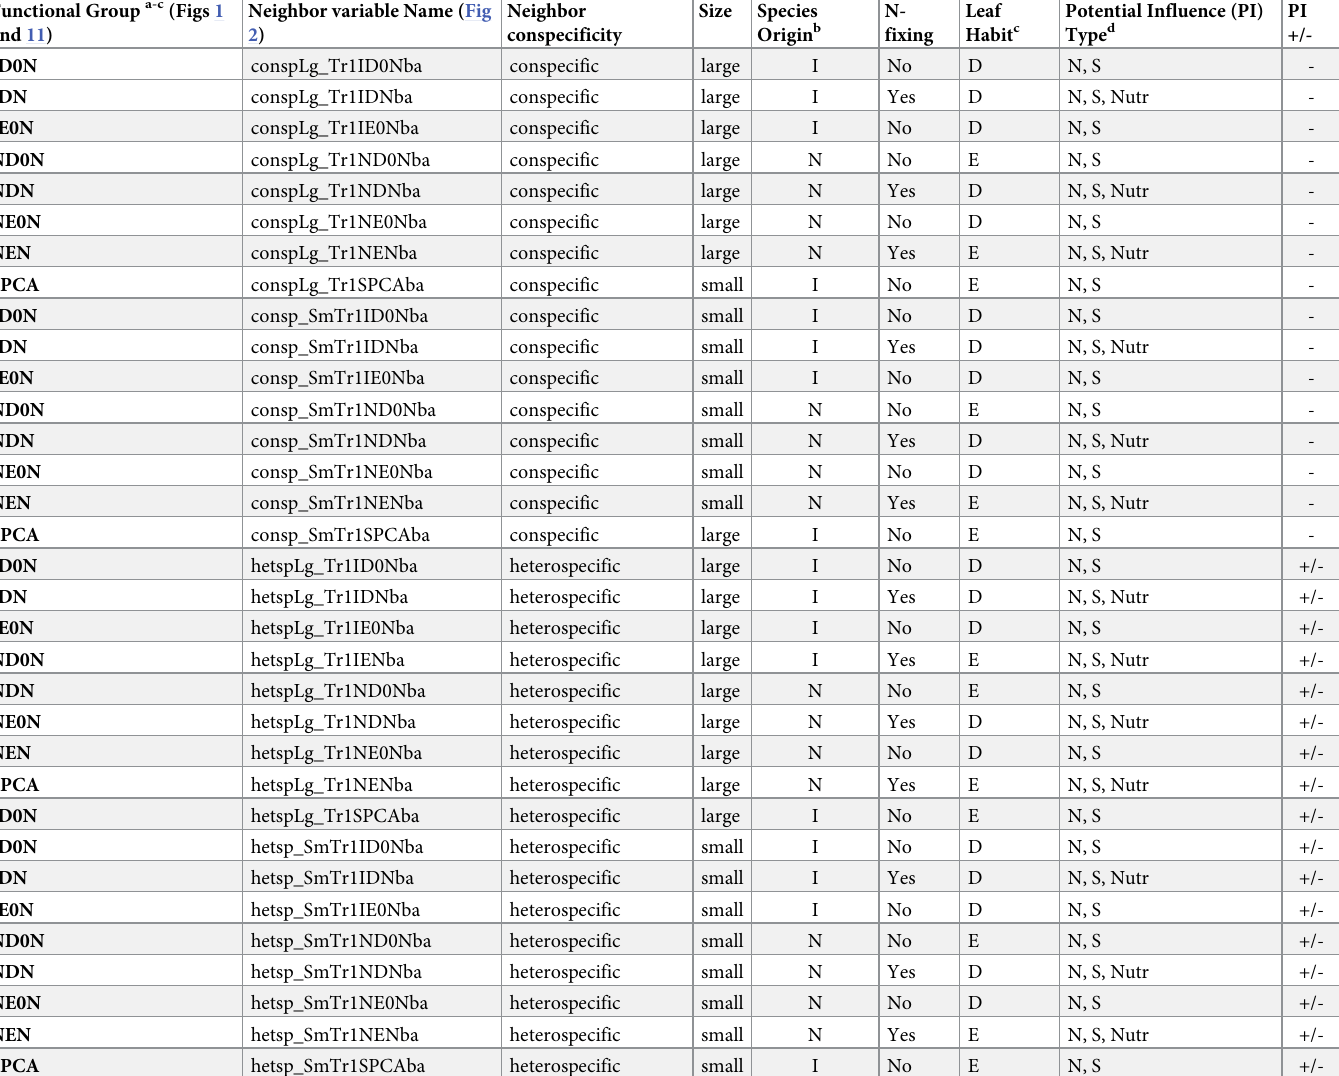
Table 2. Functional groups of potential neighbor predictor variables and influence on survival. Functional Group a-c (Figs 1 and